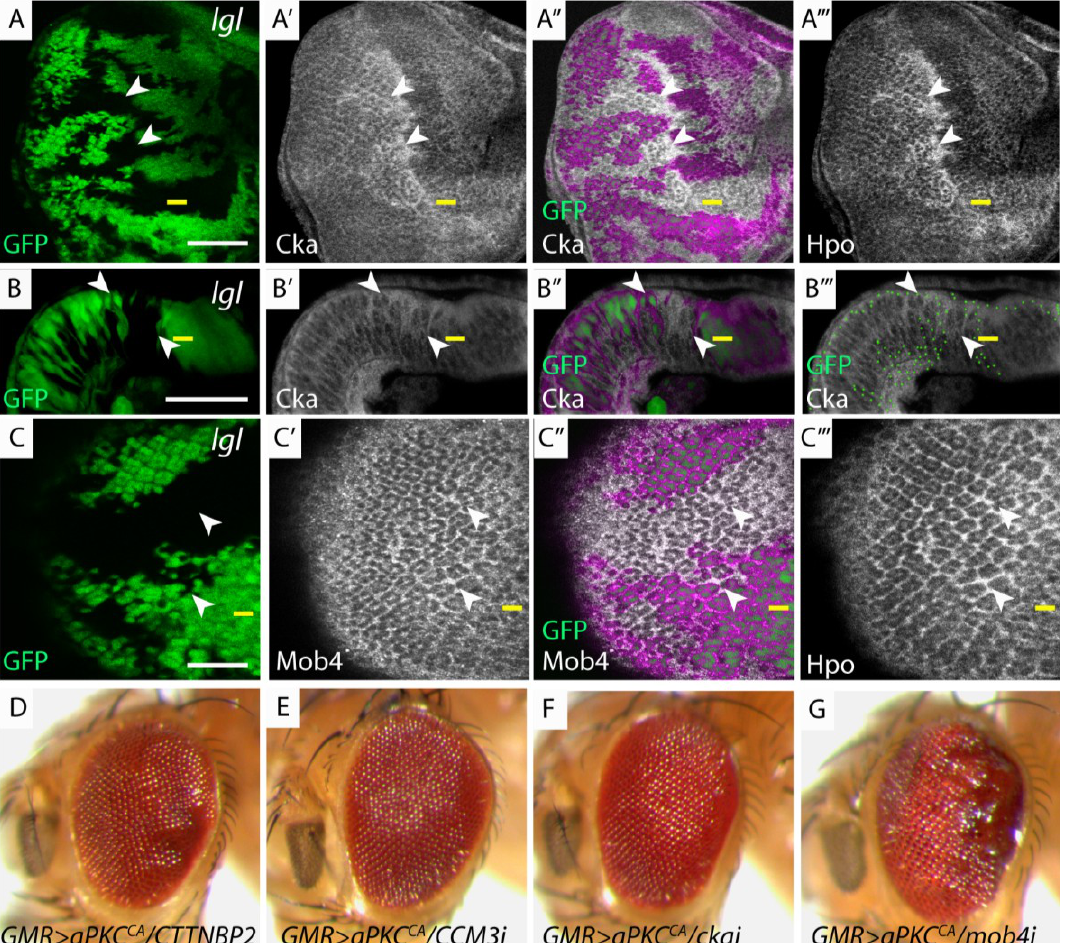
( A – C ) lgl : eyFLP ; lgl 27S3 , FRT40/UbiGFP , FRT40 ; ( D ) GMR > aPKC CA /CTTNBP2 : GMR-GAL4 >